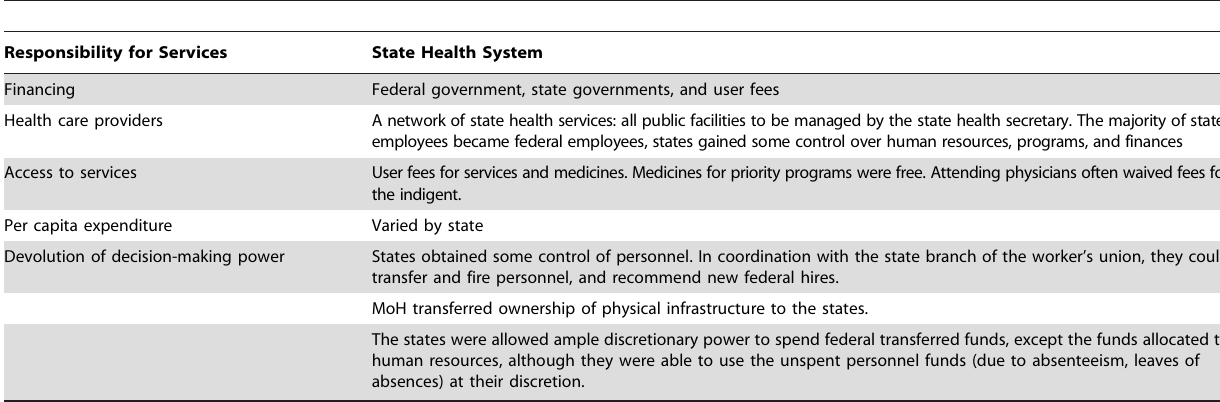
Table 4. Organization of health care for the uninsured after the second decentralization reform